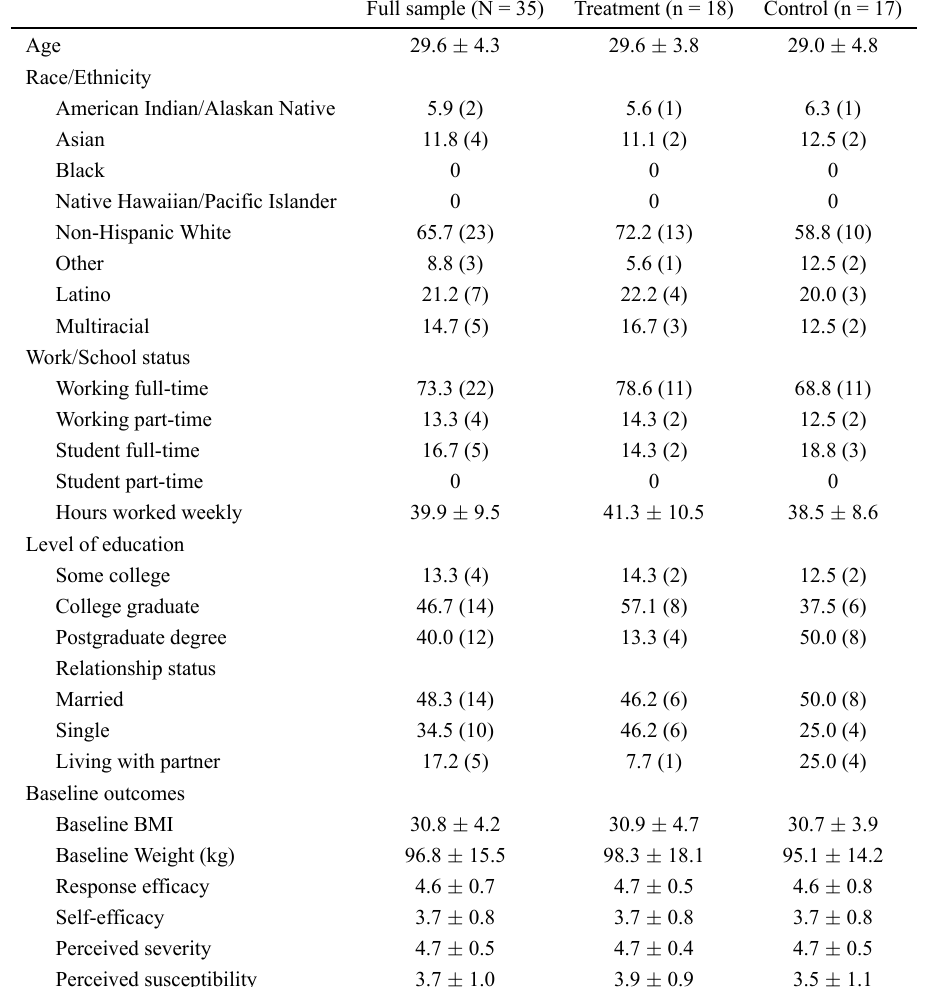
Table 1. Participant characteristics (%[n] for categorical variables and mean ± SD for continuous variables).